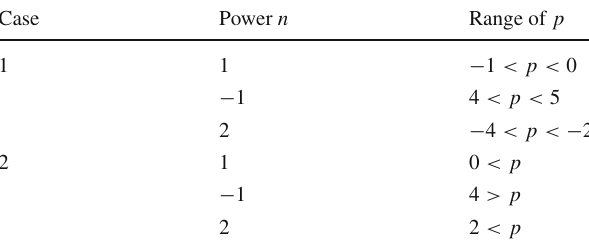
Table 3 Different values of n and their corresponding intervals of p generating the same results as those of